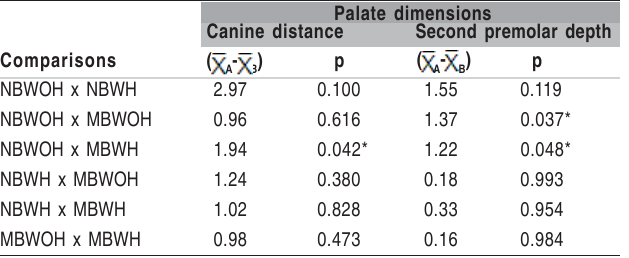
Table 4: Difference between the mean values ( significance level in the canine distance and second premolar depth measurements in the multiple comparisons considering the presence the nonnutritive sucking habits and respiratory